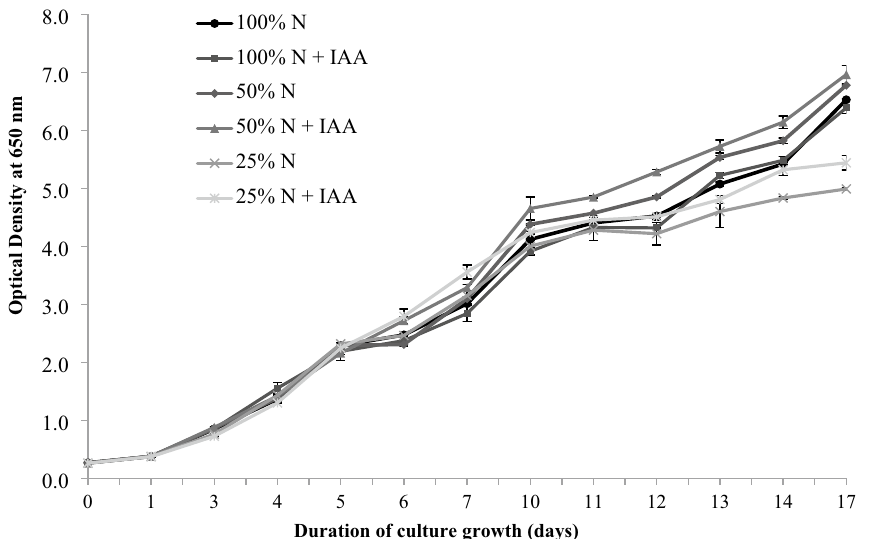
Figure 1. Growth curves of Eustigmatos calaminaris cultivated in: 100% NaNO 3 (100% N), 100% NaNO 3 and supplemented with IAA (100% N + IAA); 50% NaNO 3 (50% N) and 50% NaNO 3 supplemented with IAA (50% N + IAA); 25% NaNO 3 (25% N) and 25% NaNO 3 supplemented with IAA (25%N + IAA). Data are expressed as means (±SD), n =